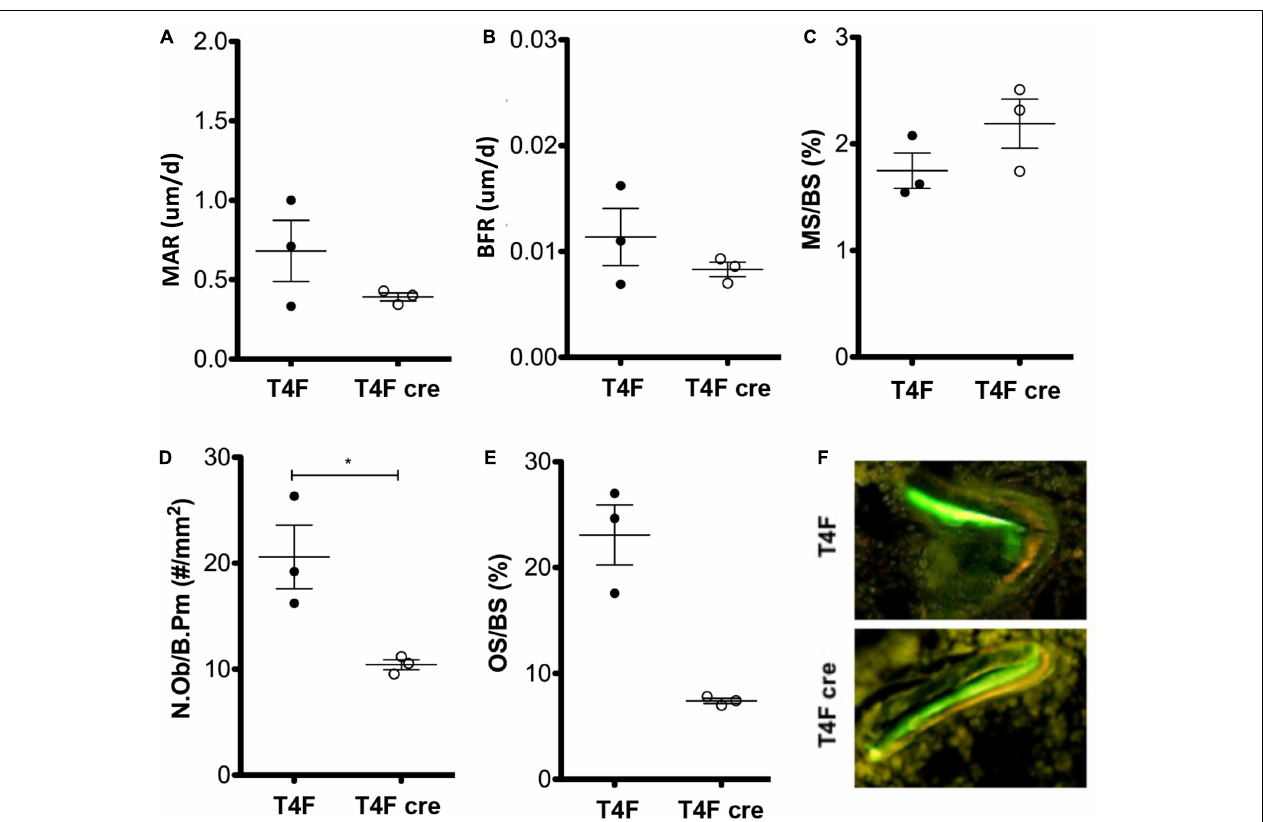
FIGURE 2 | MAR assay and trichrome staining results indicate contrasting effects of Tle4 loss on bone formation and calcification. T4F cre mice of 8-to-9 days old have decreased (A) MAR and (B) BFR rates, measurements of average bone calcification per osteoblast and total bone formation, respectively, while having similar (C) ratio of mineralizing to bone surface ratios. (D) T4F cre mice also had less N.Ob/B.Pm values, an estimate of the number of osteoblasts per area of bone surface. (E) Trichrome staining reveals T4F cre mice have significantly reduced osteoid compared to T4F controls ( n = 3 mice per arm; * p < 0.05, Student t -test). (F) Representative image demonstrating decreased bone formation in T4F cre mice vs. T4F mice via MAR double-stain of calcein and